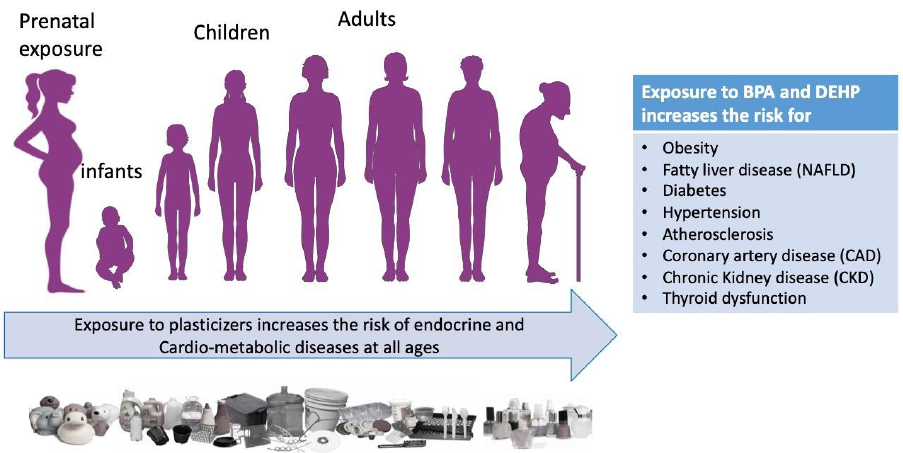
Figure 1. Long term exposure to phthalates and BPA increases the risk of cardiometabolic diseases.